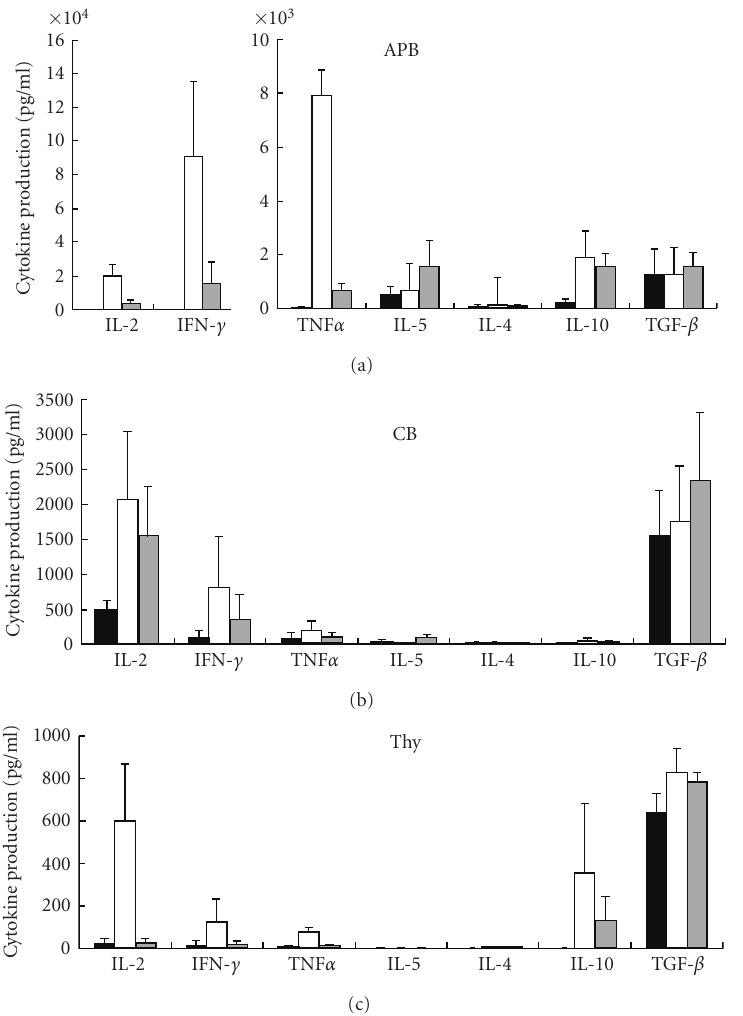
Figure 3: Suppressive e ff ect of CD4 + CD25 + T cells on cytokine production by CD4 + CD25 − responder cells. CD4 + CD25 + T cells and CD4 + CD25 − responder cells were prepared by a magnetic microbead system. Cells were stimulated with anti-CD3/CD28-mAb-coated beads in the presence of antigen-presenting cells. The supernatants were removed after 48 hours of incubation with either CD4 + CD25 + T cells (black bars), CD4 + CD25 − responder cells (white bars), and cocultured cells (gray bars). TGF- β level in supernatants was measured using ELISA, and levels of other cytokines were measured using a cytometric bead array kit. Data are mean ± SD of 3 independent